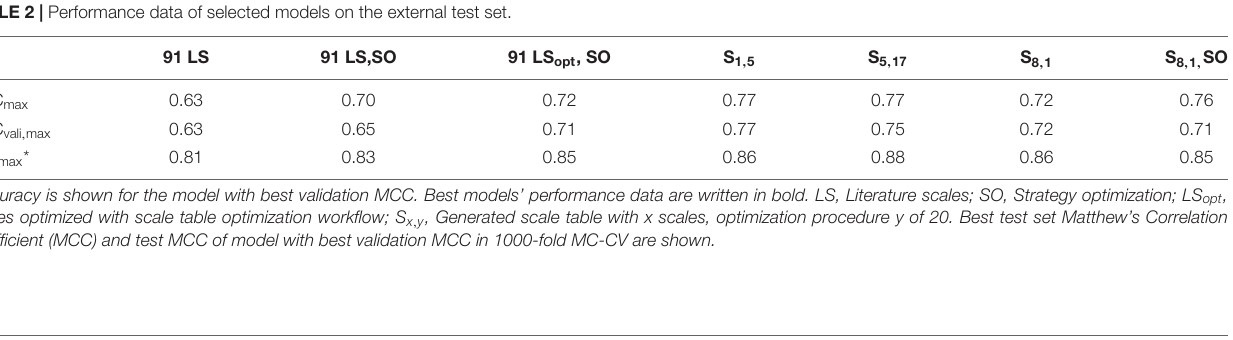
TABLE 2 | Performance data of selected models on the external test set.